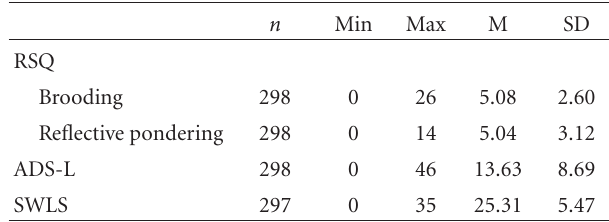
Table 2: Self-report measures across the whole